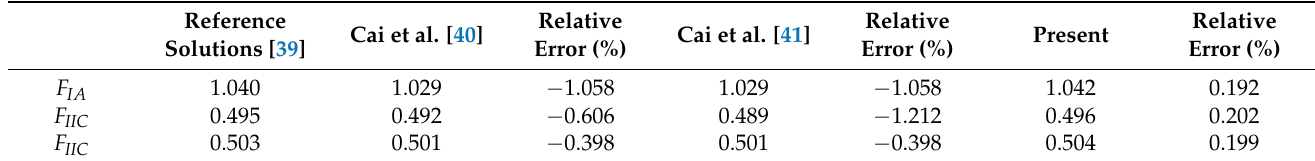
Table 9. Normalized SIFs for the branched cracks in an infinite plate.